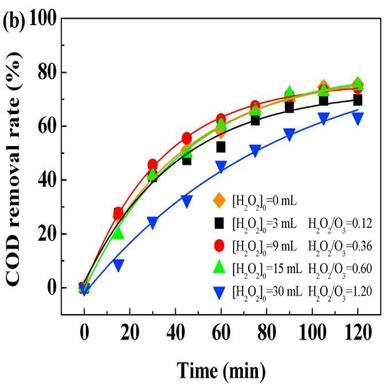
Effect of H2O2 dosage (30% H2O2 L1 leachate) on COD removal (pH ¼ 6 (RL) or 12 (BTL), 0 ¼ 25 g Nm3 ± 5%, T ¼ 25 ± 1 C). (a) raw leachate (b) bio-treated leachate.